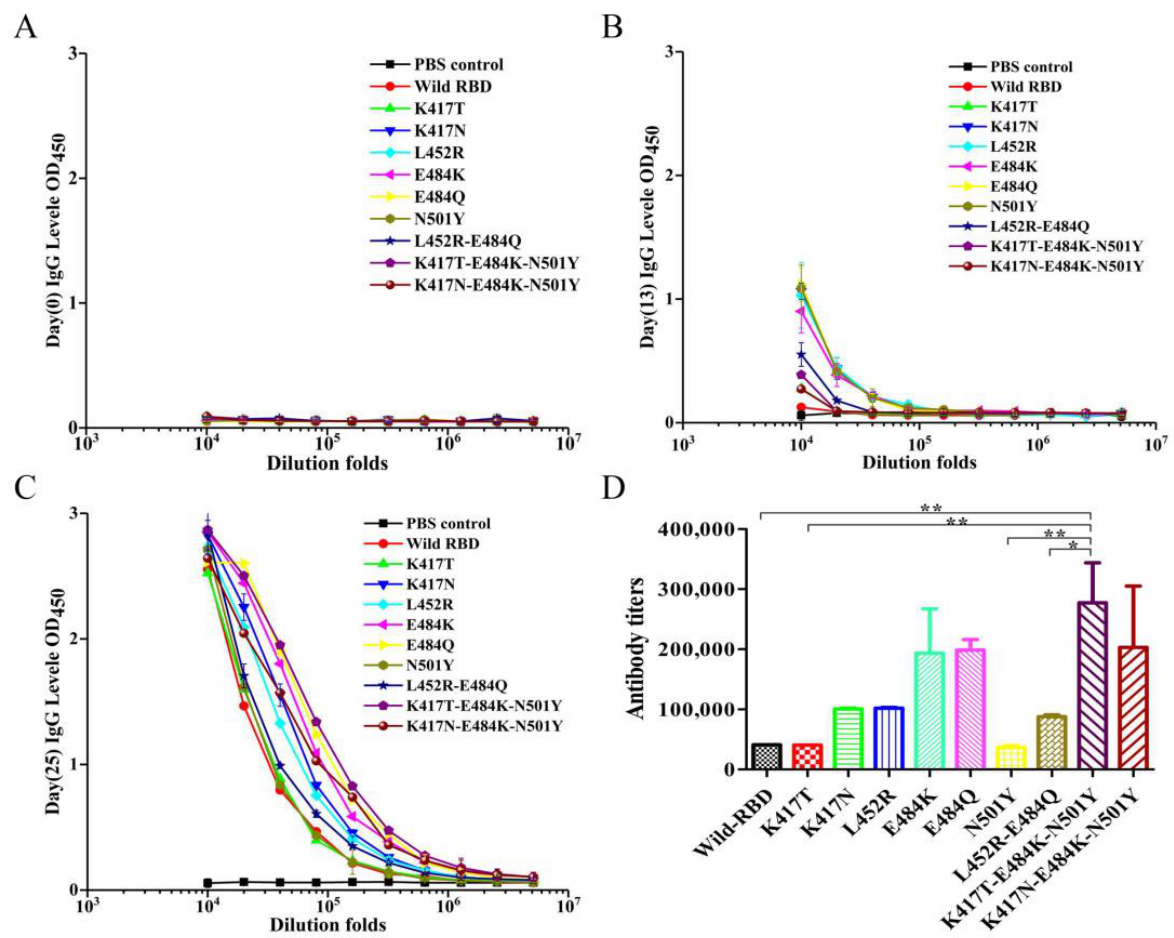
Figure 3. Anti-SARS-CoV-2 RBD antibody levels in mice by ELISA. It was coated with 100 ng of wild RBD protein, and after blocking with 2 times gradient diluted serum. ( A – C ) represent the antibody levels of RBD on days 0, 13, and 25, respectively. ( D ) The RBD antibody titers were expressed as the minimum concentration (maximum dilution) required for binding antigen. Statistical significance was defined as p < 0.05, and * p < 0.05, ** p < 0.01.